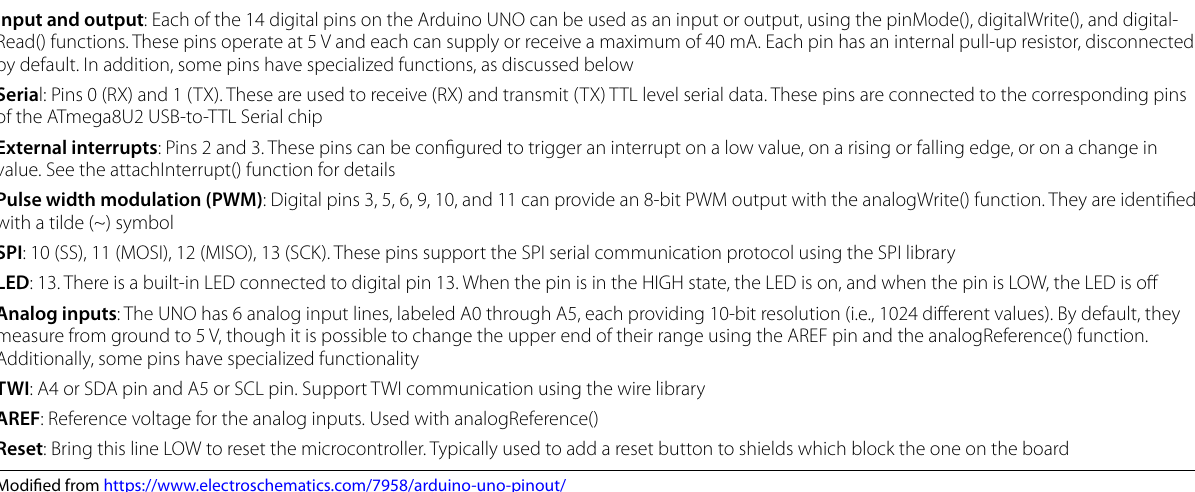
Modified from https:// www. elect rosch emati cs. com/ 7958/ ardui no- uno-